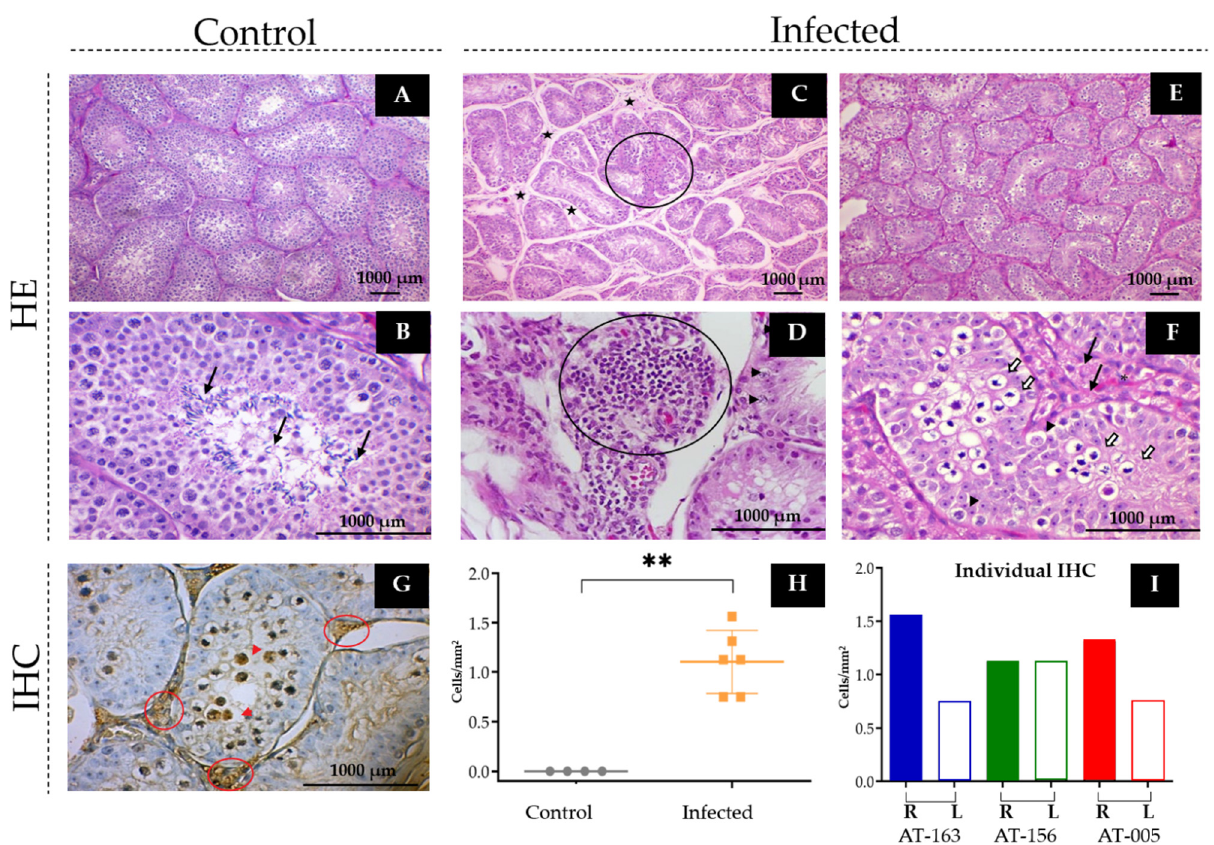
Figure 5. Microscopic evaluation of S. collinsi . ( A ) Integrity of testicular tissue from control animal AT-001 (100×). ( B ) Seminiferous tubule of the control animal, in a higher magnification lens, showing sperm (arrow), score 10 (400×). ( C ) AT-005, infected with ZIKV, showing diffuse tubular edema and tubular retraction (star). Highlighted (circle) interstitial cell proliferation associated with inflammatory infiltrate (100×). ( D ) Perivascular inflammatory infiltrate (circle), with the presence of lymphocytes and neutrophils. The seminiferous tubule of an infected animal, showing a decrease in the number of germ cells, which are degenerated (arrowhead) (400×). ( E ) AT-163 infected animal, showing proliferation of Leydig cells and degenerated germ cells. ( F ) Infected animal, showing seminiferous tubule containing degenerating spermatogenic cells (hollow arrows), presence of pyknotic nuclei and cytoplasmic macrovacuolization (arrowhead), score 4. In the extra tubular area, there is an increase in the proliferation of Leydig cells (black arrows) (400×). ( G ) Light micrograph showing IHC staining with peroxidase using anti-ZIKV polyclonal antibodies. Seminiferous tubule from infected animal AT-005, showing ZIKV antigen labeling on both the germ cells of the seminiferous tubule (arrow) and the Leydig cells (circle). ( H ) Graph showing the quantification of viral antigen per group in the testicular tissue of the control and infected animals. ** p < 0.03. ( I ) Graph showing the quantification of ZIKV antigen per animal based on the IHC test. In blue is the animal AT-163, in green the AT-156 and in red the AT-005; the filled columns represent the right testis and the empty columns the left testis. Table 3. Seminiferous tubule ( n = 10 per testicle) measurements and Johnsen’s score of squirrel monkeys ( Saimiri collinsi ) on the 21st day following infection with Zika virus.